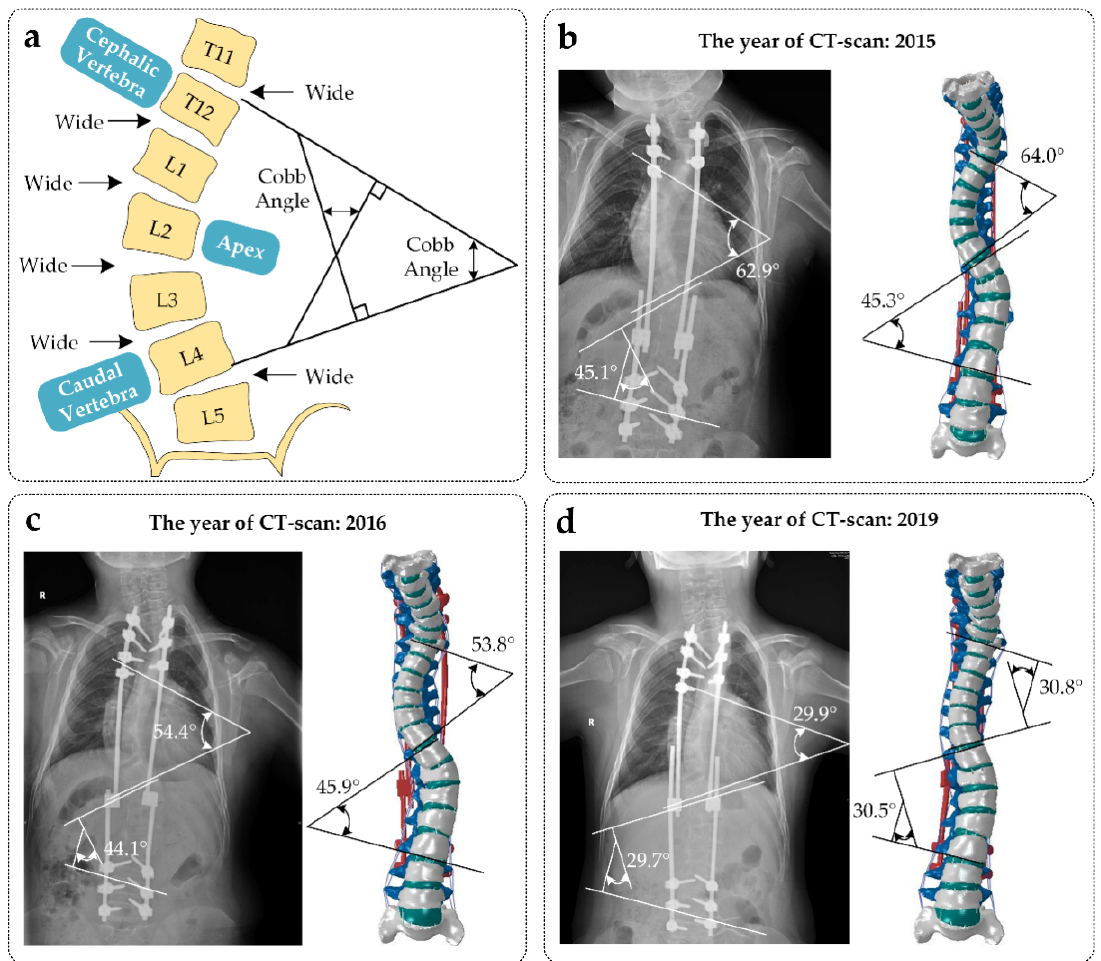
Figure 1. ( a ) Definition method of Cobb angle. The Cobb angle is the angle of intersection between the vertical of the superior edge of the cephalic vertebra and the vertical of the inferior edge of the caudal vertebra. ( b – d ) contain the CT taken after the patient’s first surgery (2015), the patient’s second surgery (2016), and the patient’s third surgery (2019). The reconstructed model conforms to the CT images.